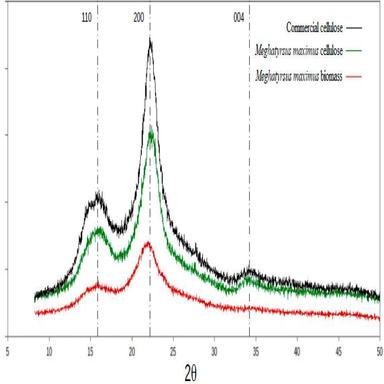
XRD diffractogram for MMB, MMC and CC.